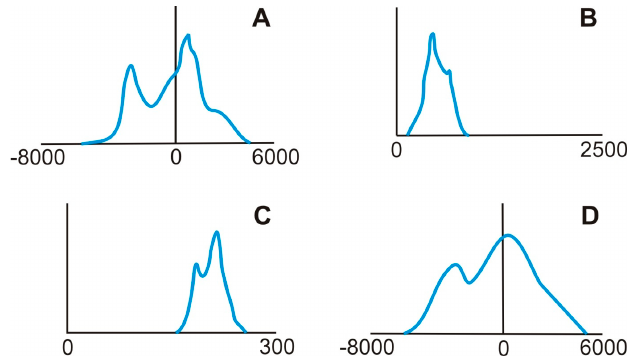
Figure 3. Changes in histograms when employing the proposed histogram matching method combining the Empirical line and Gaussian stretch: ( A ) histogram of the PC1; ( B ) histogram of the WorldView-2 (WV2) panchromatic (PAN) band; ( C ) histogram of the WV2 PAN band after Empirical line histogram matching; and ( D ) histogram of the WV2 PAN band after Gaussian stretch in the original PC1 values range.